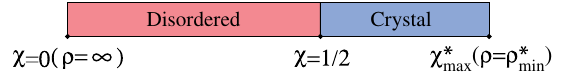
FIG. 14. Phase diagram for the entropically favored stealthy ground states in the canonical ensemble as a function of χ which applies to the first four space